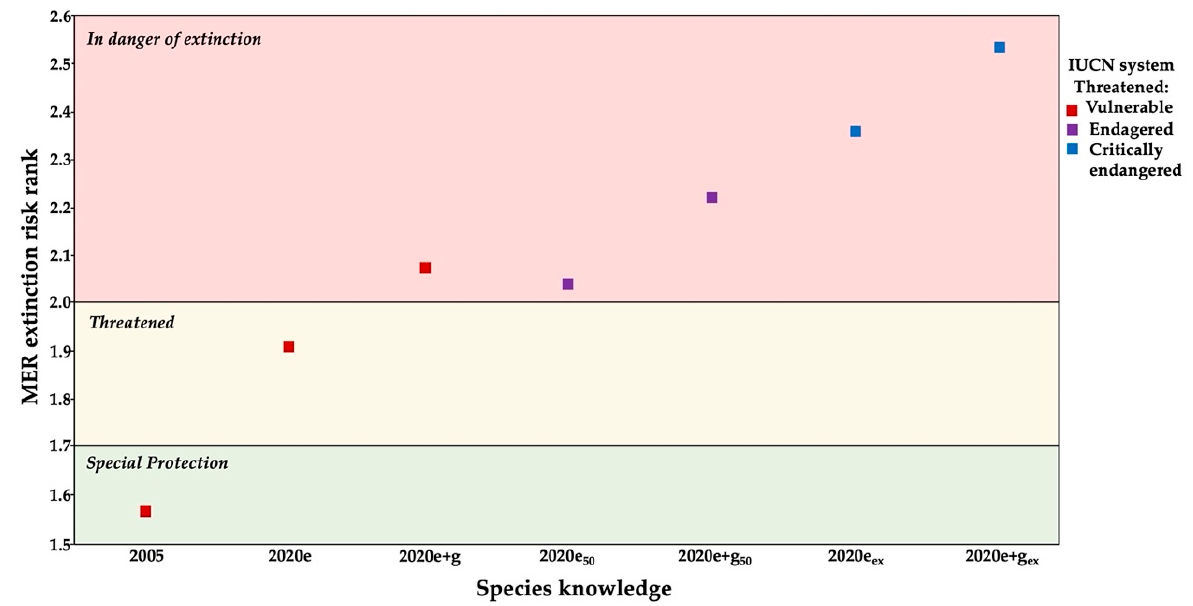
Figure 7. Comparison of the Mexican national system (MER) and IUCN Red List in Pachyphytum caesium among years based on ecological and genetic knowledge. Ecological data, average (2020e), with loss of 50% of individuals (2020e 50 ) and local extinction of two populations (2020e ex ); ecological and genetic data, average (2020e + g), with loss of 50% of individuals (2020e + g 50 ) and local extinction of two populations (2020e + g ex ).